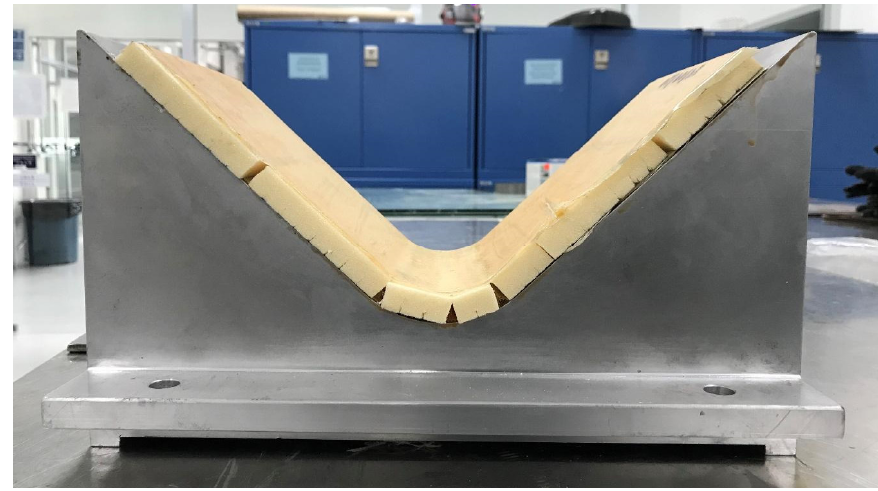
Figure 5. Picture corresponding to the gridding foam specimen placement in the V ‐ shaped mold before the preheated process.